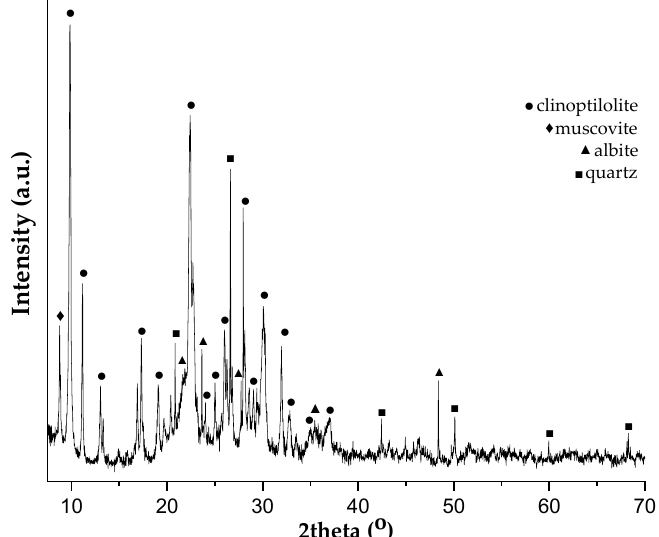
Figure 1. X-ray diffraction pattern of the zeolitic tuff sample.